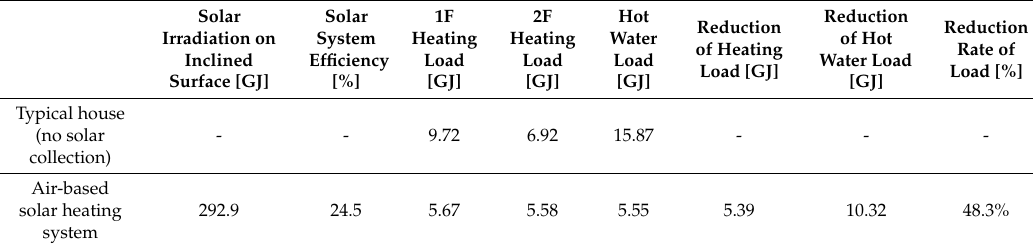
Table 7. Load reduction effect of the air-based solar heating